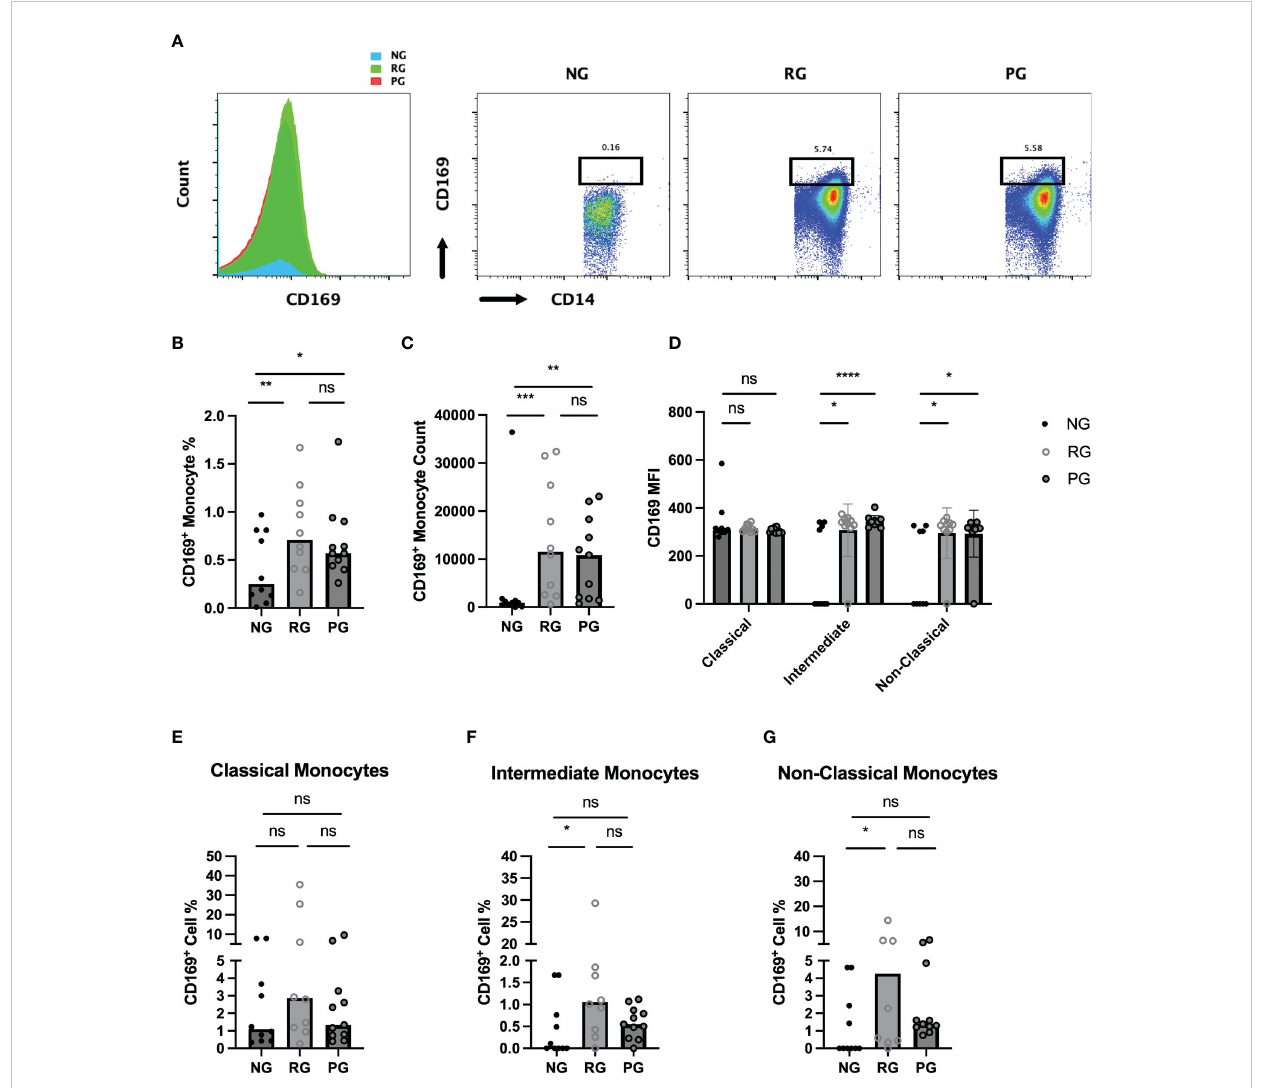
FIGURE 4 Characterization of circulating CD169 + monocytes in NG, RG, and PG groups. Representative histogram and dot plot of CD169 + /CD14 + monocytes in NG, RG, and PG groups. Percentage of total CD169 + monocytes from total CD14 + monocytes is shown above the gate (B). Total CD169 + monocyte percentage from CD45 + cells, (C) CD169 + monocyte, (D) MFI of CD169 on monocyte subsets in NG, RG, and PG. The percentage of CD169 + cells identi fi ed in (E) classical monocytes, (F) intermediate monocytes, and (G) non-classical monocytes within NG, RG, and PG groups.